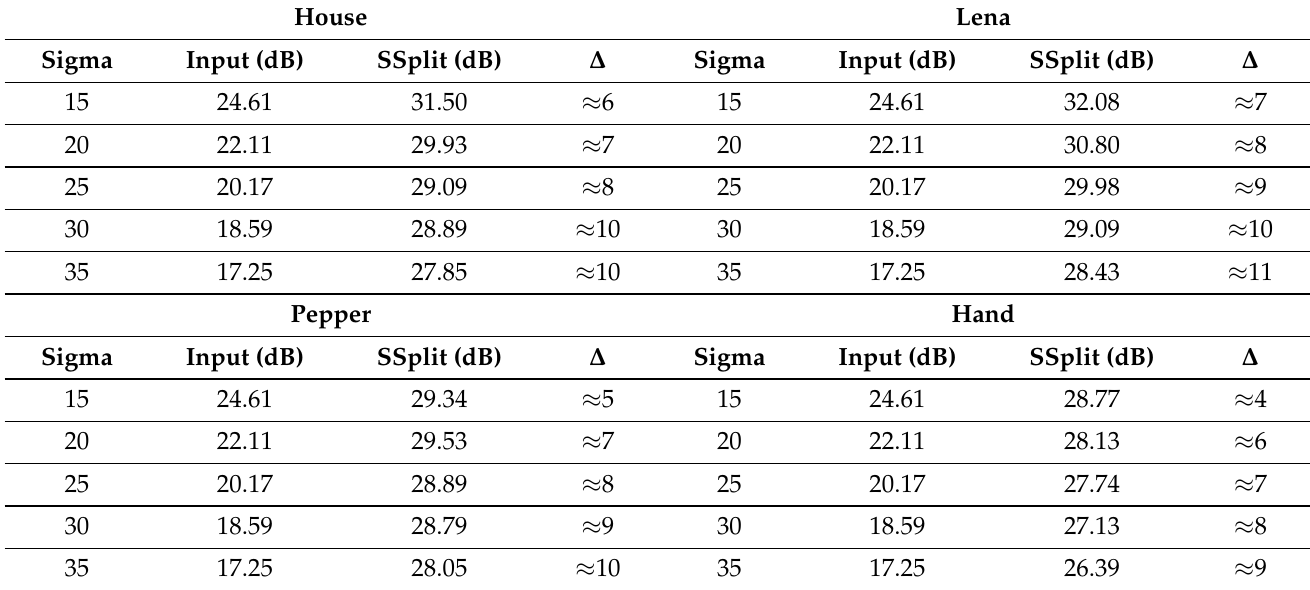
Figure 15. ( a ) Original Image, ( b ) Image with the addition of Gaussian white noise (Input PSNR = 18.59 dB), ( c ) Denoising with proposed method (Output PSNR = 26.82 dB). Table 1. Obtained results on House, Lena, Pepper and Hand image with different noise levels